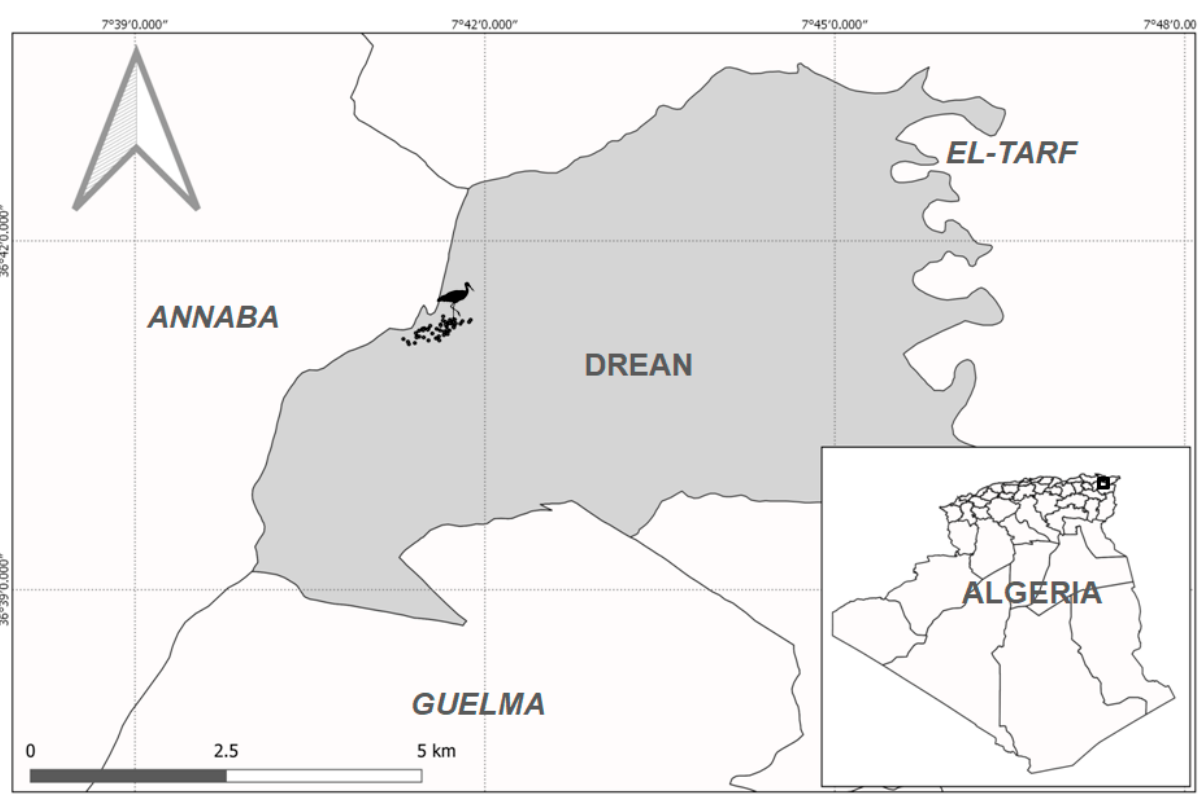
Figure 1. Map of Numidia, north-eastern Algeria, with the location of the studied white stork col- ony.